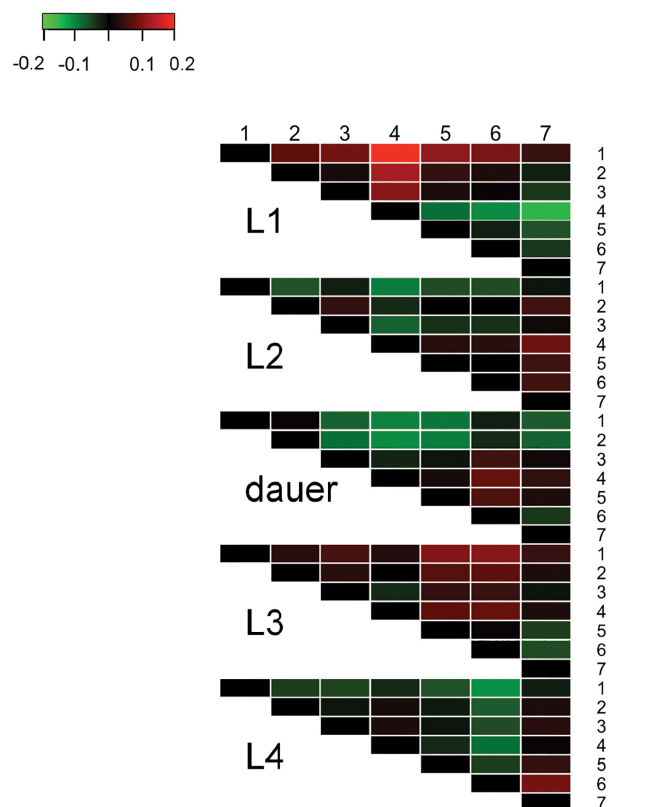
Fig 6. Heat map showing differences between raters for the predicted proportion of worms assigned to each stage of development. The brightness of the color indicates relative strength of difference between raters, with red as positive and green as negative. Result are shown as column minus row for each rater 1 through